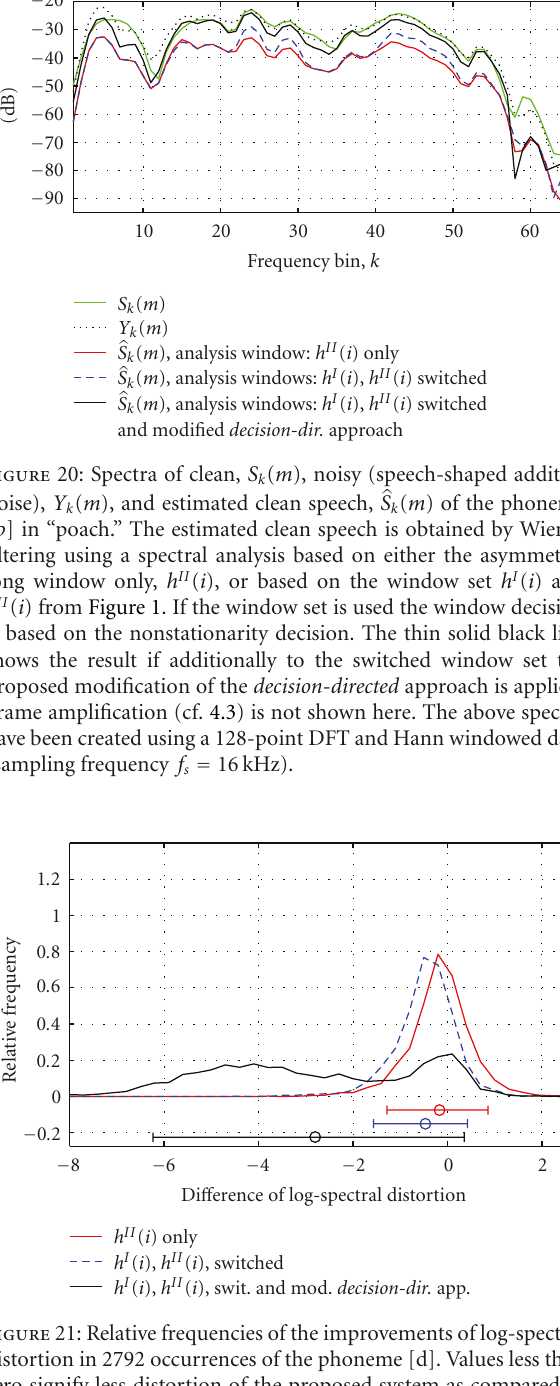
Y k ( m ) (dotted black line), are also